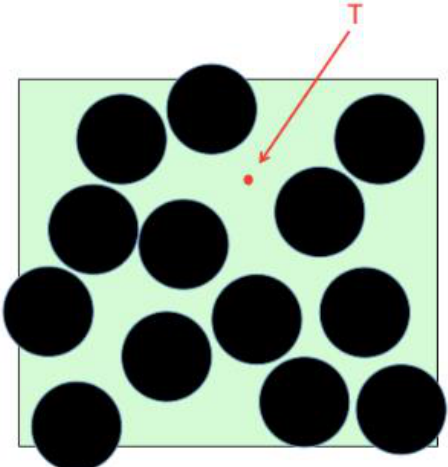
Figure 6. The available volume (green) for a small molecule (red circle) in a highly concentrated solution of macromolecules (black circles). The volume occupied by the macromolecules is the exclusion volume.